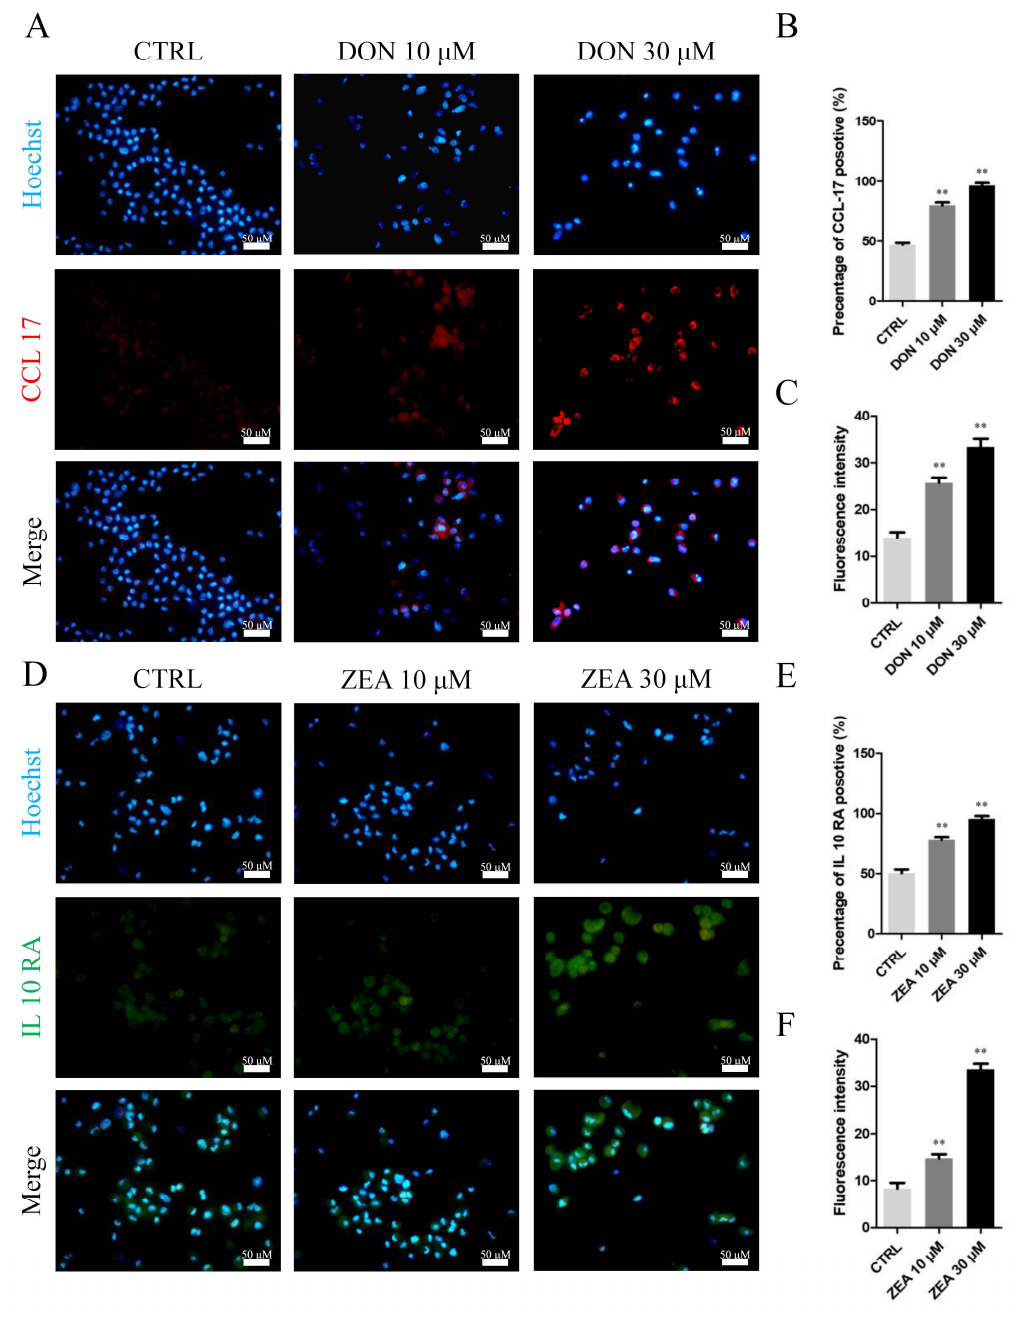
Figure 8. Immunofluorescence assay probing the expression of SC phosphor- CCL17 ( A ), and IL10RA ( D ) proteins in the DON and ZEA treatment groups. The percentages of positive cells ( B , E ) and fluorescence intensity ( C , F ) were analysed. Bar indicates 50 μm. Data are presented as the means ± SD. ** p < 0.01.